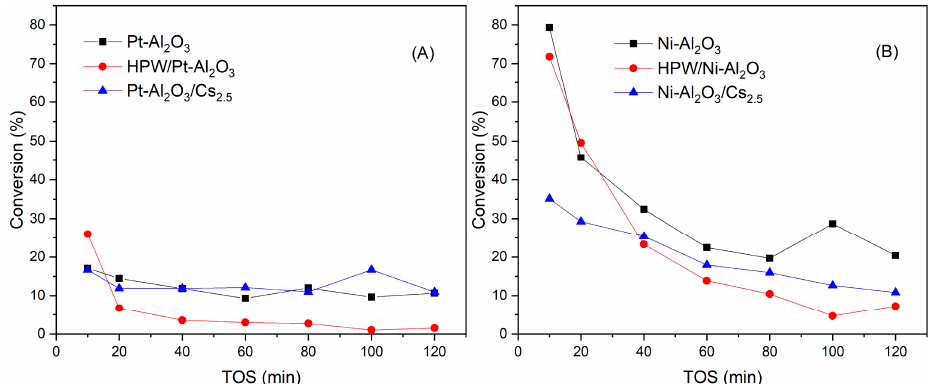
Figure 10. Guaiacol conversion as a function of time-on-stream for Pt-Al 2 O 3 catalysts ( A ) and Ni-Al 2 O 3 catalysts ( B ) series.